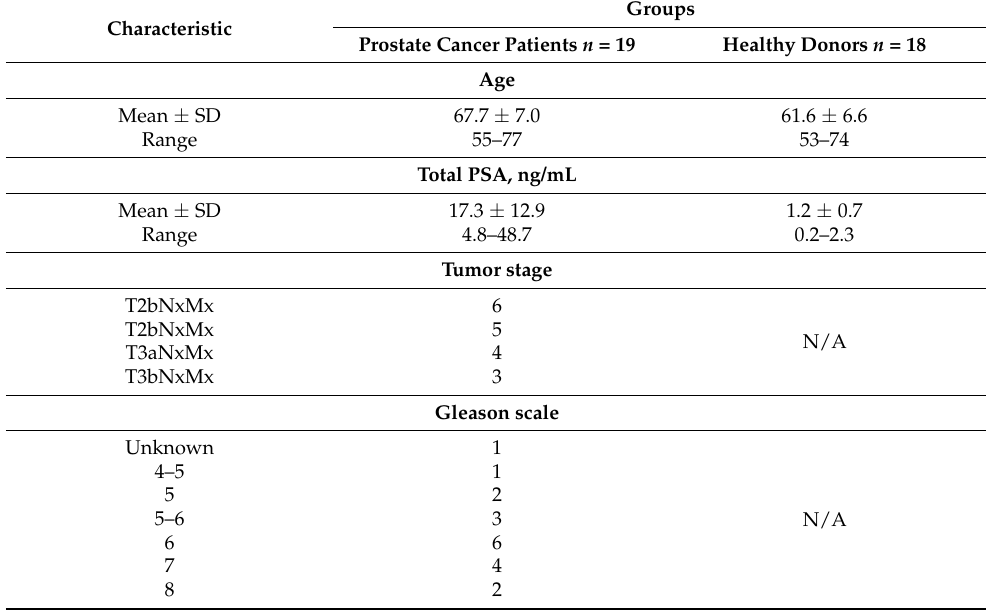
Table 1. Overview of the study